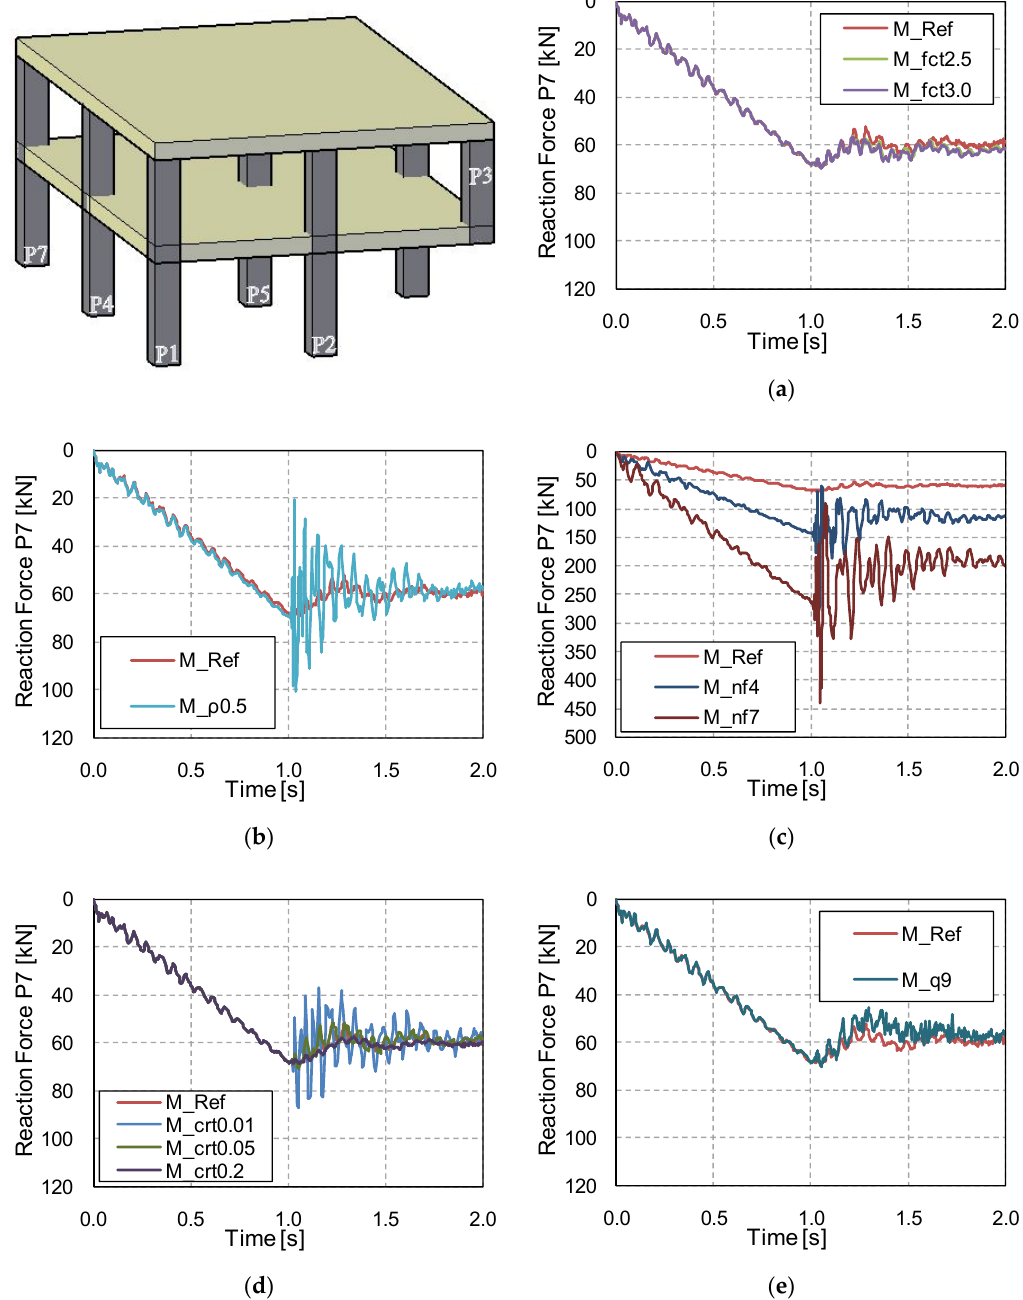
Figure A4. Numerical reaction in P7 obtained by varying ( a ) concrete tensile strength, ( b ) flexural reinforcement ratio, ( c ) number of floors, ( d ) column removal time and ( e ) superimposed load. Positive values indicate compression.